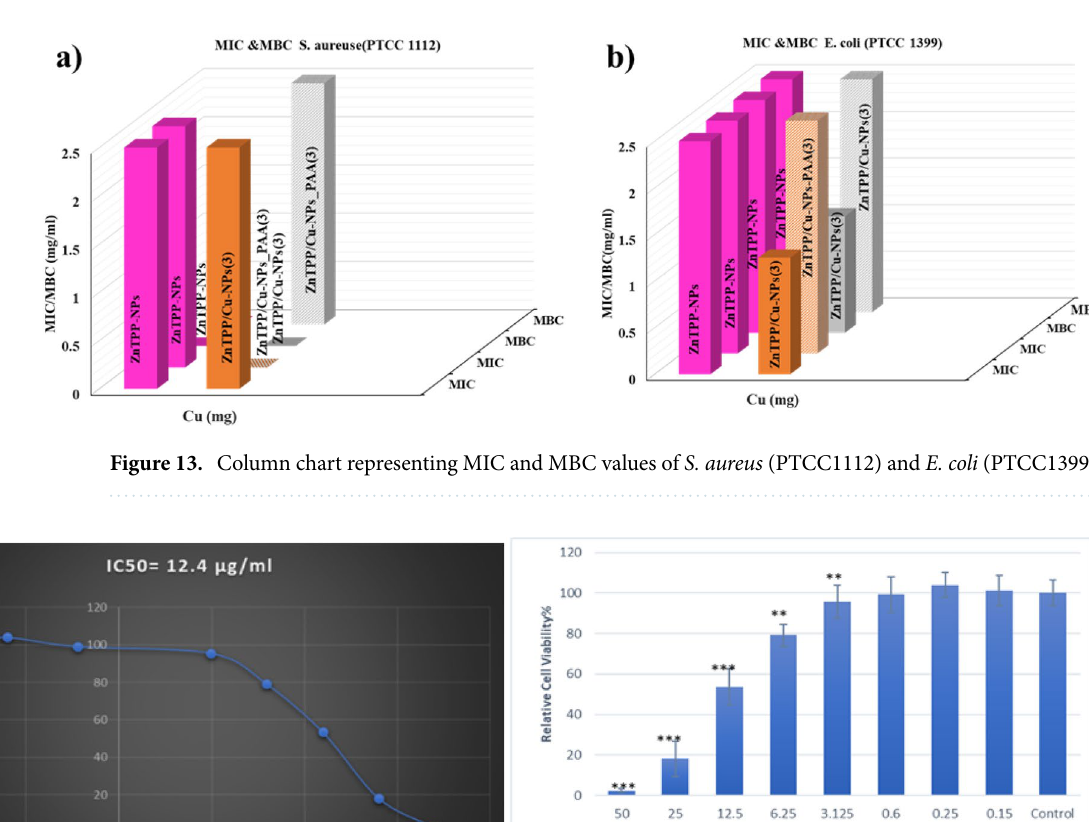
Table 3. MIC and MBC value for E. coli and S. aureus strains for all samples. a For all MIC and MBC the concentration is mg/mL. b In the table the (−) means “Not done”.